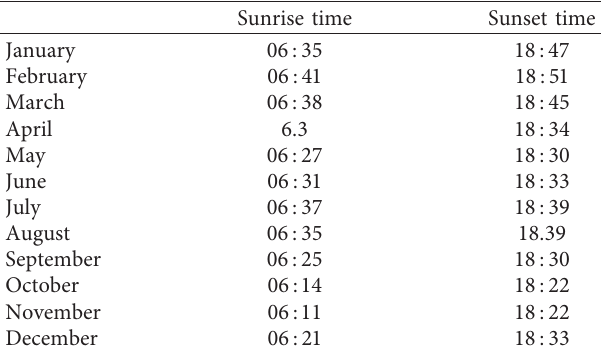
Table 1: Sunrise and sunset times. Sunrise time Sunset